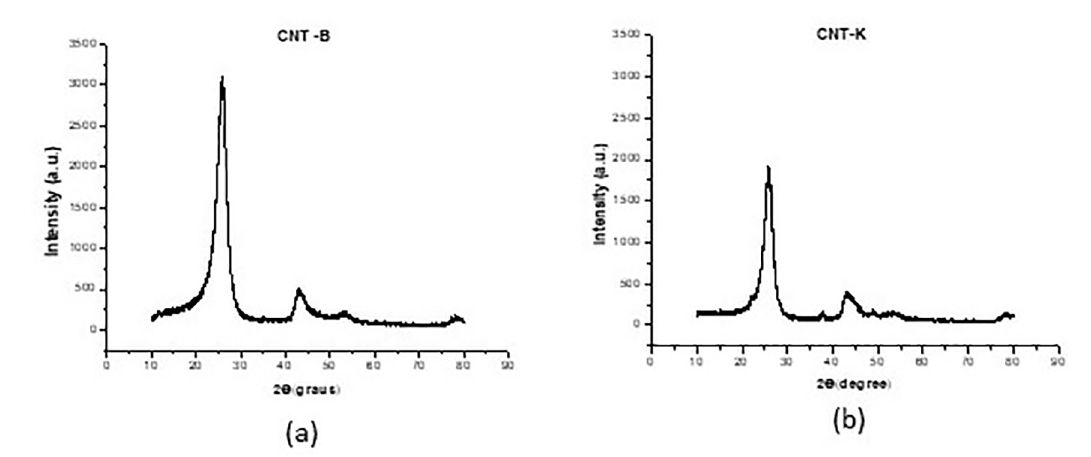
Figure 5. XRD patterns of (a) CNT-B and (b) CNT-K Table 2. Crystallographic parameters (FWHM, d of layers) of CNT-B and CNT-K samples.